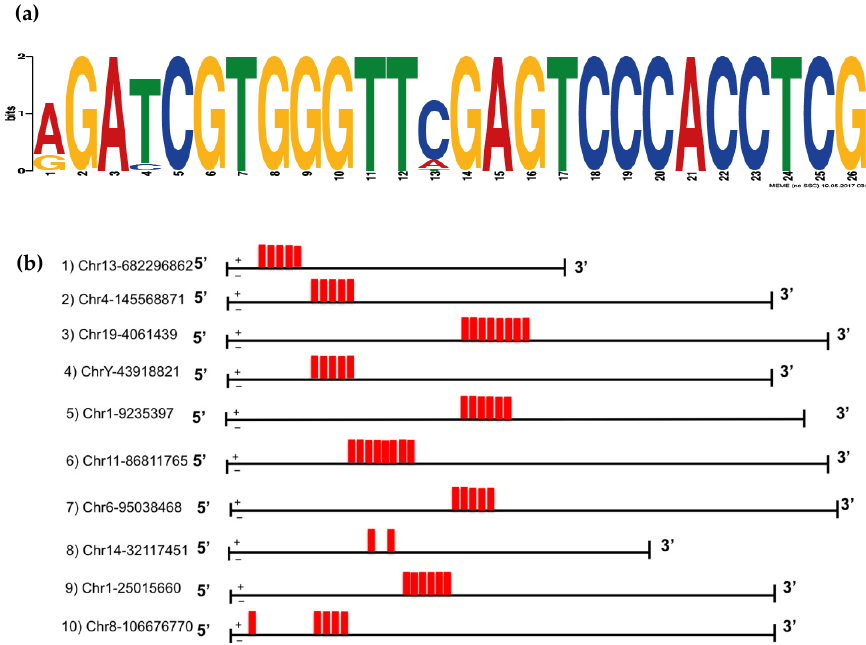
Figure 3. SEV-enriched VL30 isoforms contains a tandemly-repeated motif. ( a ) Using MEME, a 26 nucleotide motif was identified within the ten VL30 isoforms that showed the greatest SEV enrichment. ( b ) The location of this motif (red box) is shown within each of the ten VL30 isoforms that showed the greatest SEV enrichment. The chromosomal location of the 5`-end for each isoform is shown (mm10).